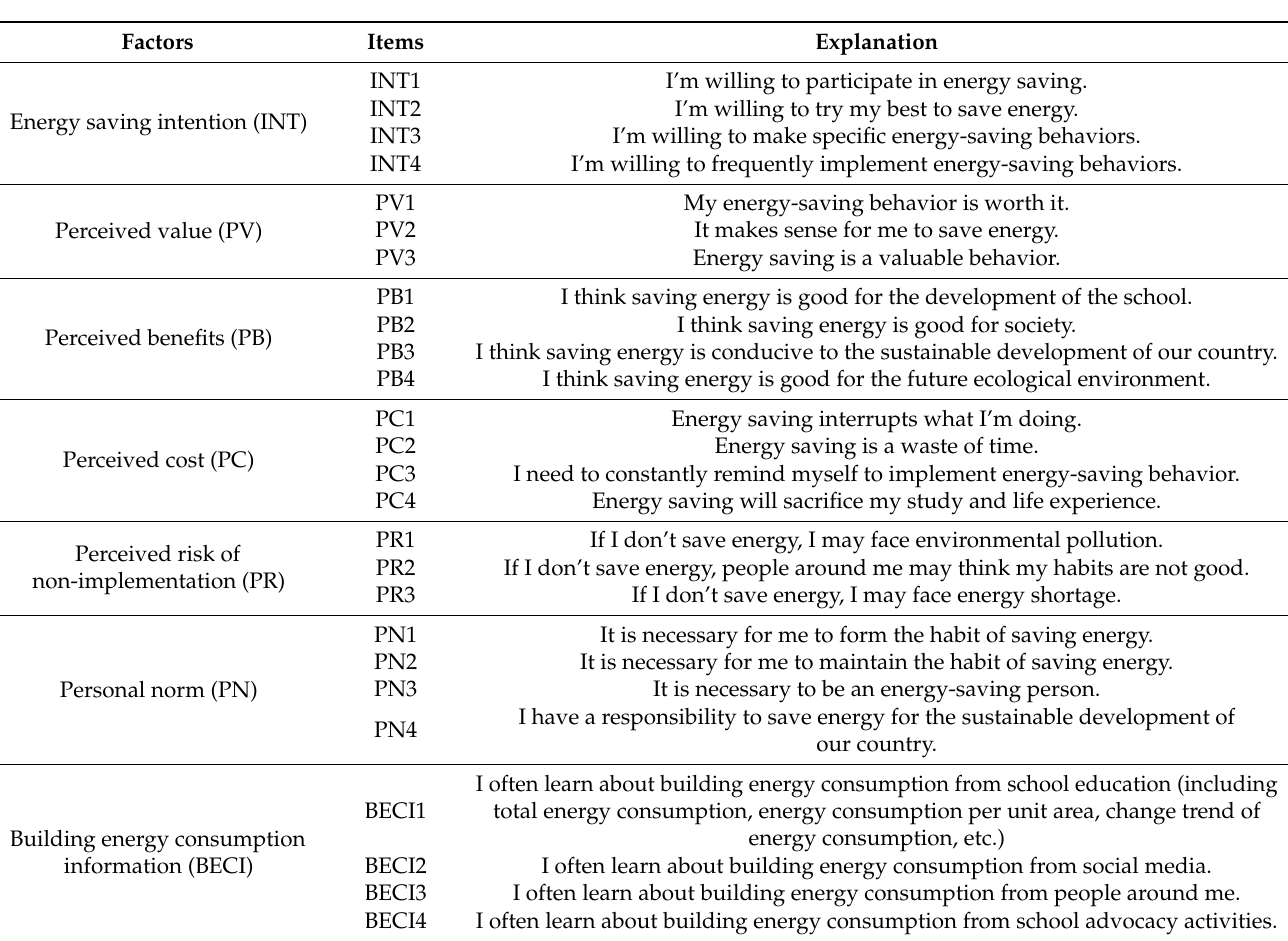
Table A1. Questionnaire Items Employed in the Main